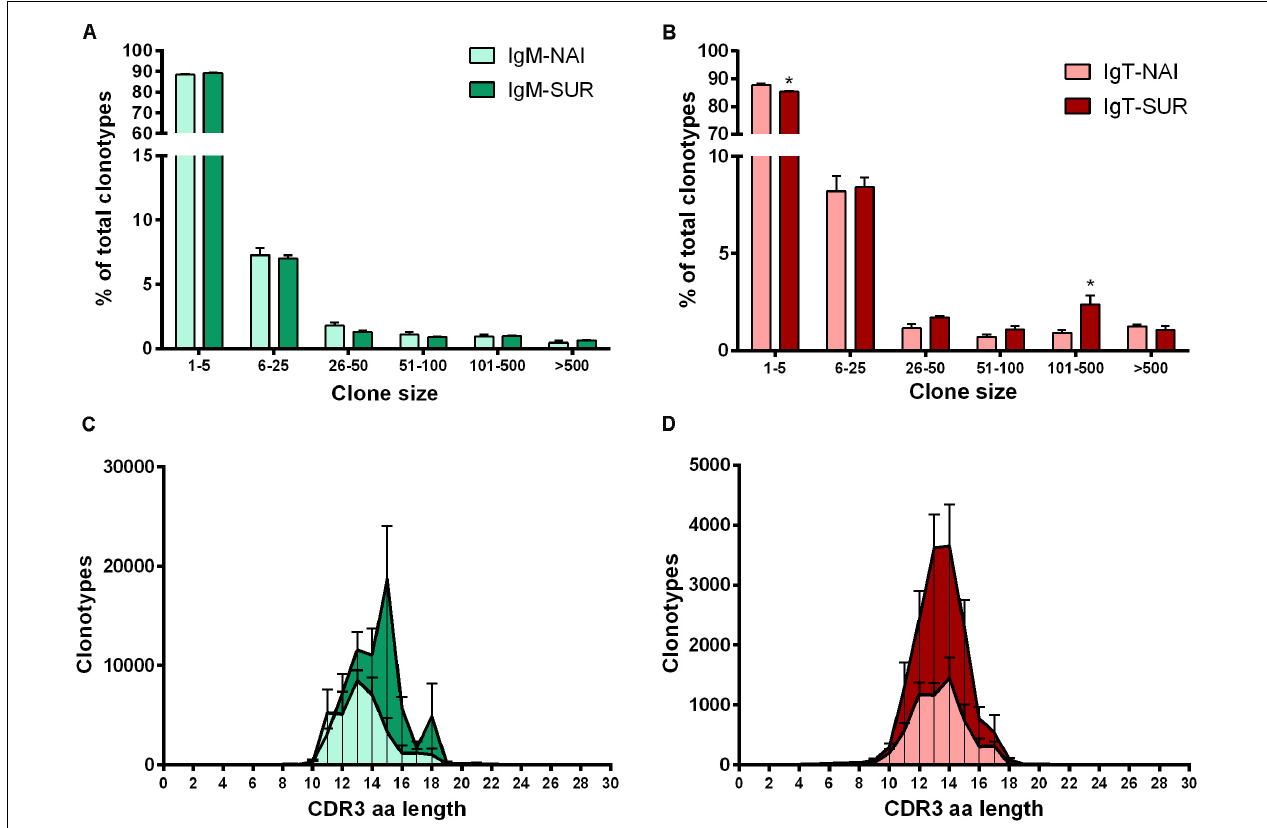
FIGURE 6 | Clonal size distribution of IgM (A) and IgT (B) clonotypes in naïve (NAI, n = 4) fish and fish that acquired resistance to Enteromyxum leei (SUR, n = 4). Bars show the average percentage (mean + SD) of clonotypes observed n times in the datasets. Asterisks represent statistical differences between NAI and SUR groups at P < 0.05. CDR3 length distributions for all detected IgM (C) and IgT (D) clonotypes. The graphs represent the average number of clonotypes of a given amino acid (aa) length (+SD) for SUR and NAI fish. Kolmogorov–Smirnoff tests reported that none of the curves followed a bell-shaped Gaussian distribution ( P >